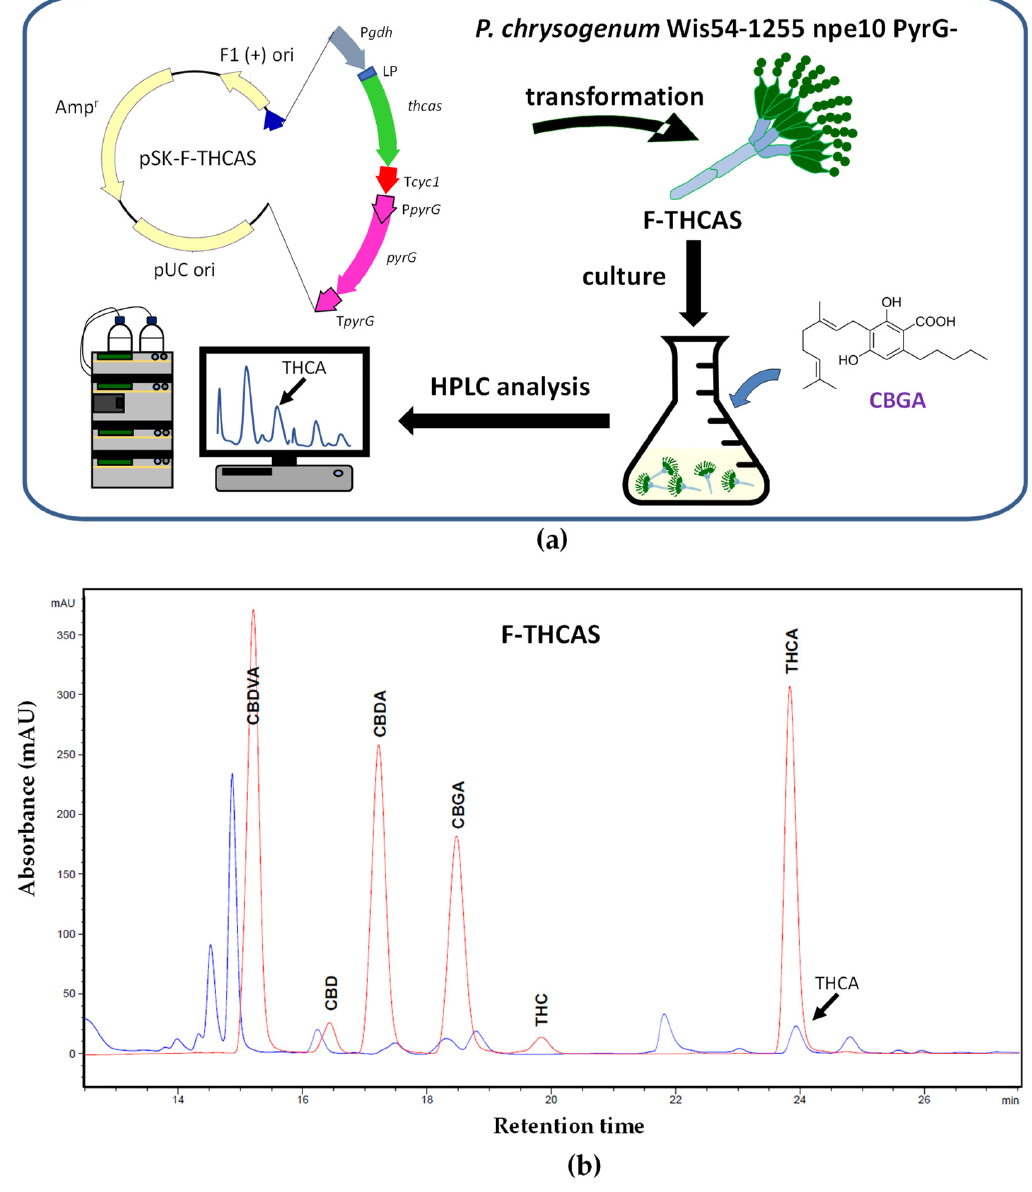
Figure 3. Production of Δ 9 -THCA in P. chrysogenum after feeding CBGA to the culture medium. ( a ) Schematic representation of the strategy followed to produce Δ 9 -THCA from CBGA in P. chryso- genum . Plasmid pSK-F-THCAS included: P gdhA ( A. awamori glutamate dehydrogenase gene pro- moter), T cyc1 (transcriptional terminator of the S. cerevisiae cyc1 gene), LP (signal peptide), thcas ( Δ 9 - tetrahydrocannabinolic acid synthase gene), and PyrG expression cassette. ( b ) Representative chro- matogram at 270 nm of one of the transformants of the F-THCAS strain showing the formation of Δ 9 -THCA (blue line). Cannabinoid standards are included (red line).